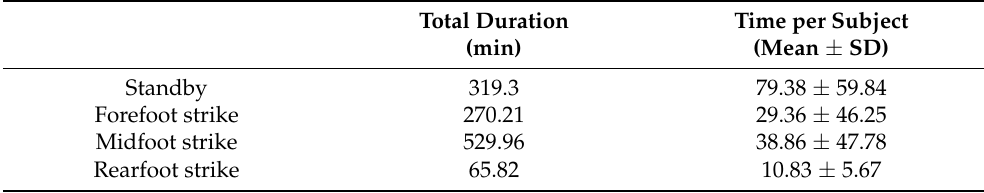
Table 2. Data acquired while running with different